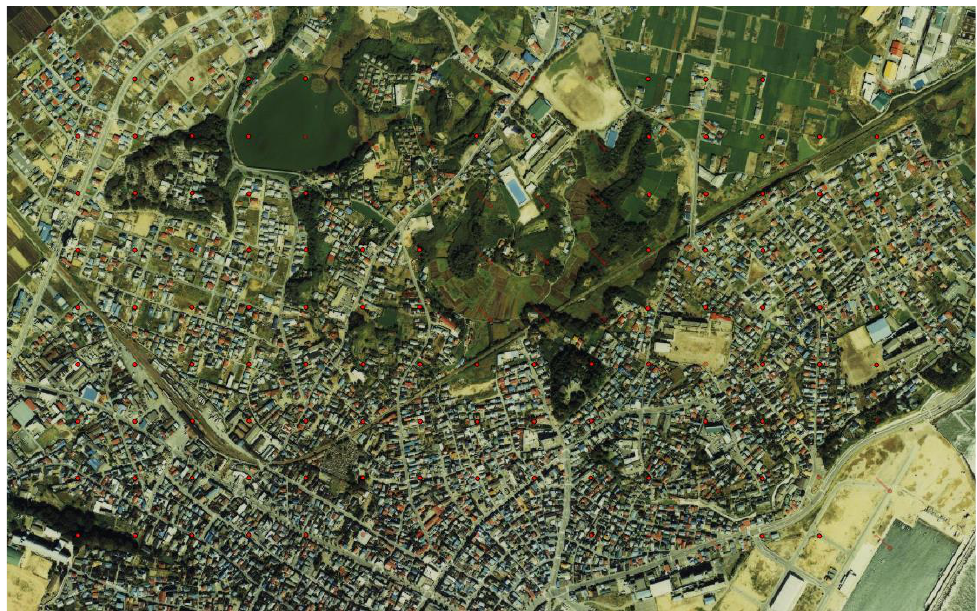
Figure 17. Tie points and residual vectors obtained by proposed method in Hitachinaka area. Figure 18 shows a mosaic of the reference image (WV-3) and the registered images (old-period aerial photos 1 and 2 and the new-period aerial photo). In the mosaicked image, the boundaries between images are consistent and no misalignment can be seen, indicating that the registration by the method worked as expected.